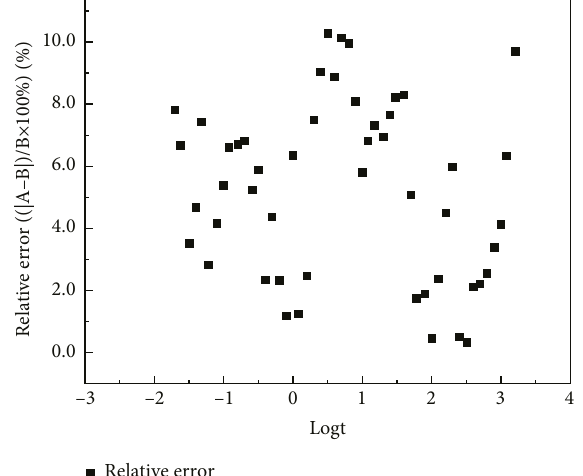
Figure 12: Relative error between predicted value and measured